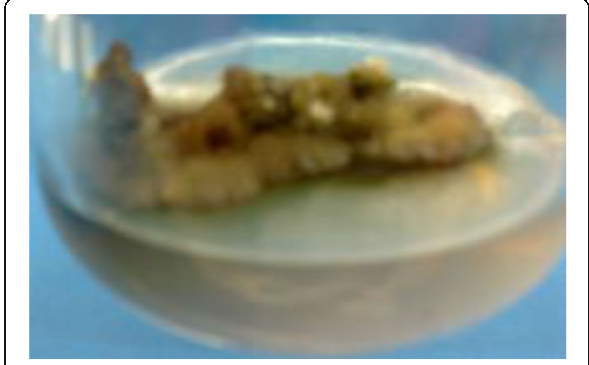
Fig. 2 Callus induction from internode explant cultured on